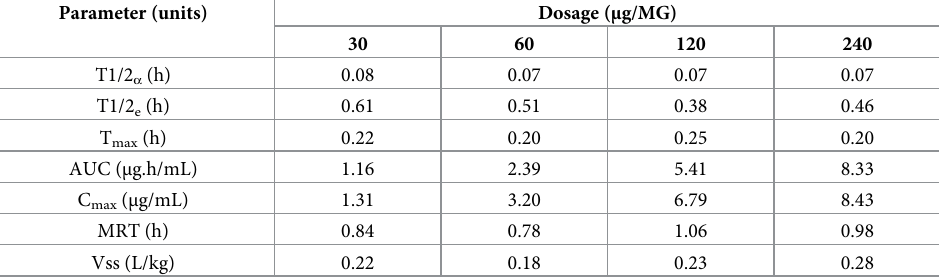
T 1/2 α indicates the absorption half-life; T 1/2e represents the elimination half-life; T max denotes the time to achieve the maximum concentration; the AUC represents the area under the concentration-time curve; C max indicates the maximum plasma concentration; MRT indicates the mean residence time; Vss represents the volume of